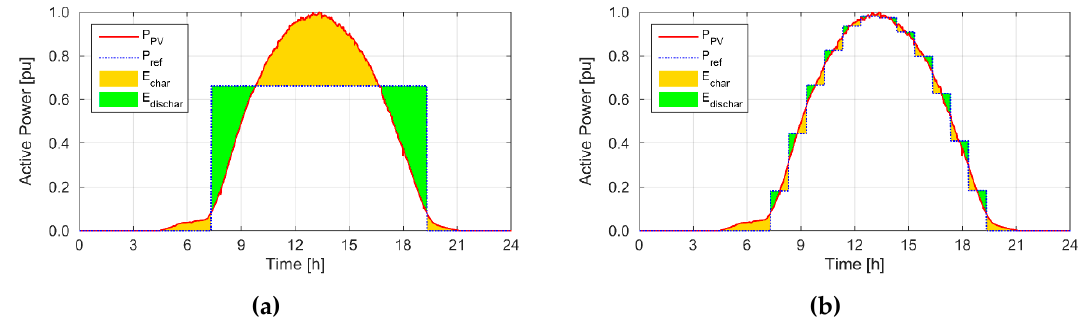
Figure 4. Hybrid power plant operation: ( a ) where the declared power is constant throughout the period of market participation, ( b ) where the declared power changes during market participation .